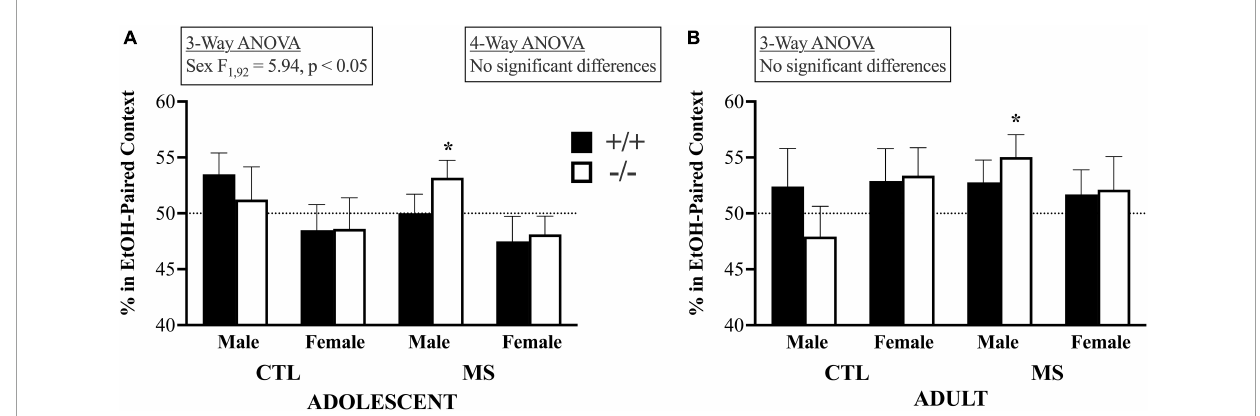
FIGURE5 Initial subjective reward to EtOH as measured by a single-exposure conditioned place preference assay did not differ by age or treatment. In fact, there was no evidence of initial subjective rewarding effects of alcohol except in MS male β -E deficient mice that preferred a context previously associated with a single injection to 1.5 g/kg EtOH over one associated with saline injection.Panels (A) and (B) show choice behavior in adolescent and adult subjects, respectively. Bars depict group means and SEM, there were between 7 and 17 subjects in each group, and * indicates group means significantly above the null hypothesis of 50%. See text for full discussion of